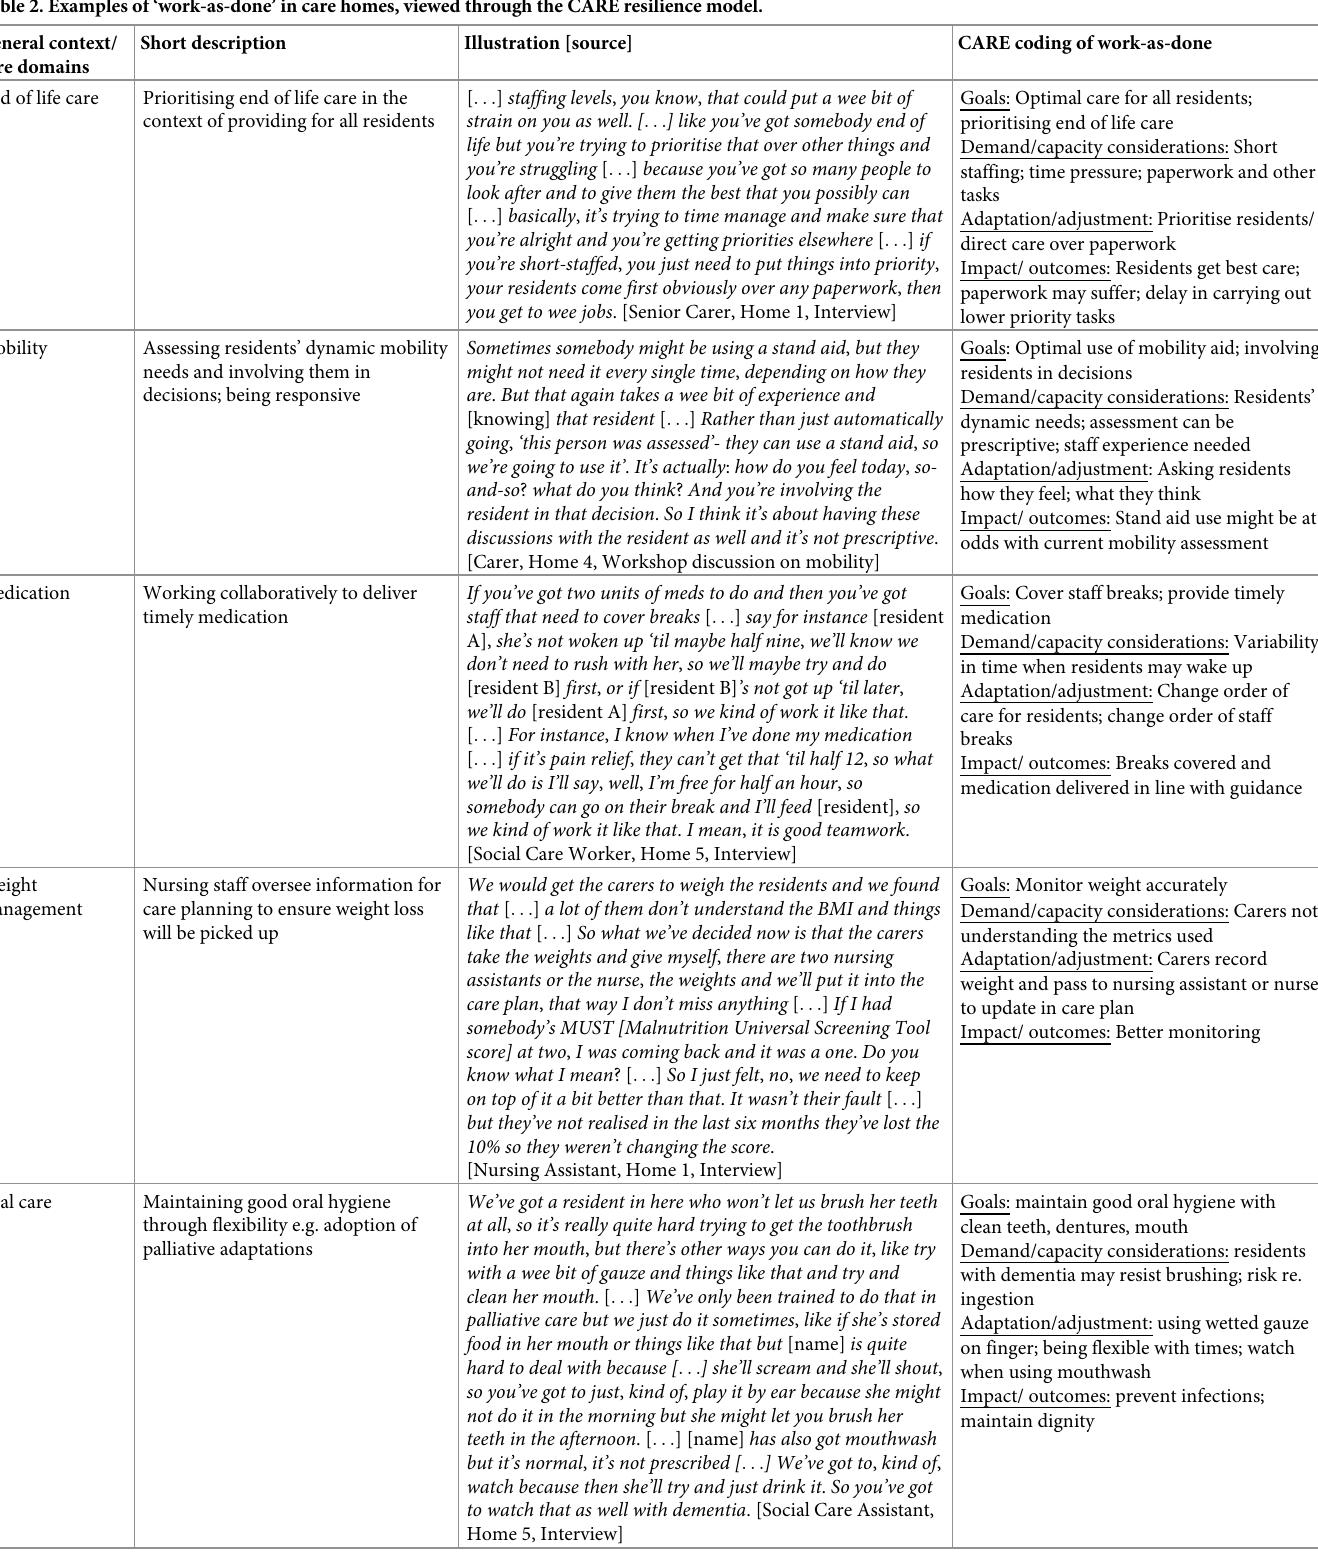
Table 2. Examples of ‘work-as-done’ in care homes, viewed through the CARE resilience model. General context/ care